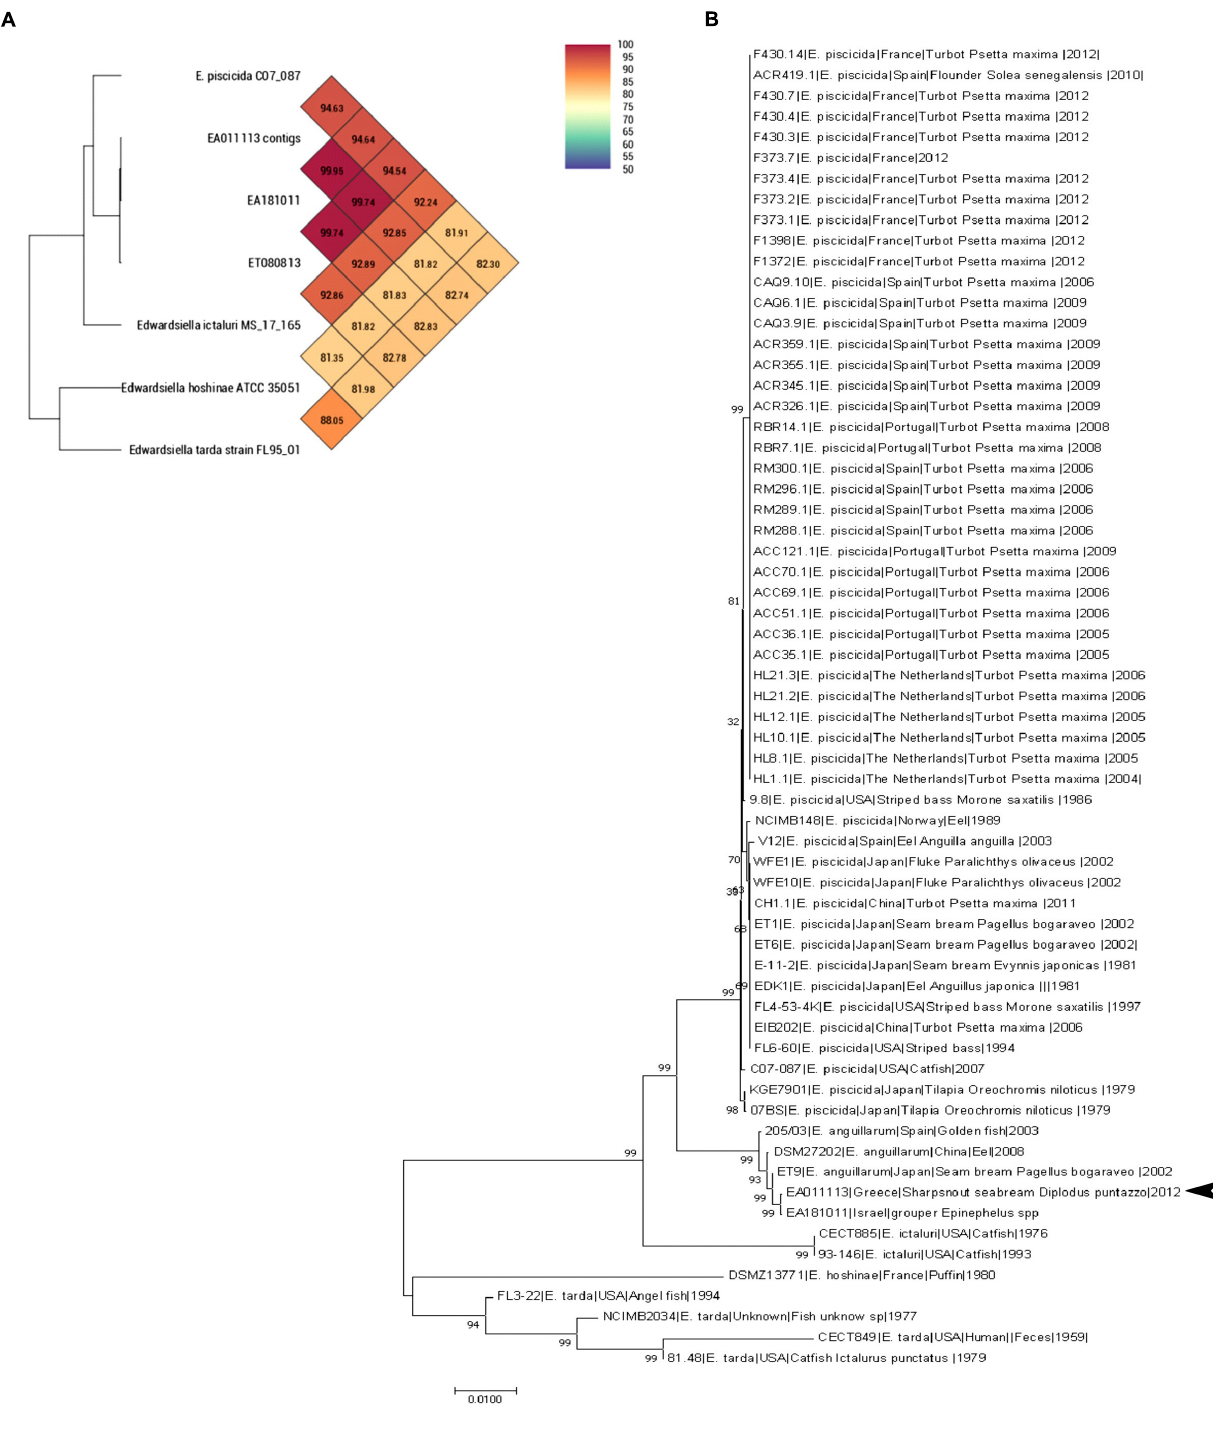
Frontiers in Microbiology |